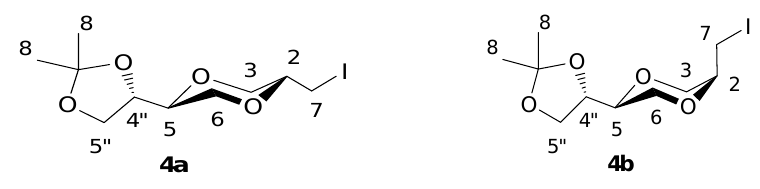
Figure 3. Structures 4a and 4b .